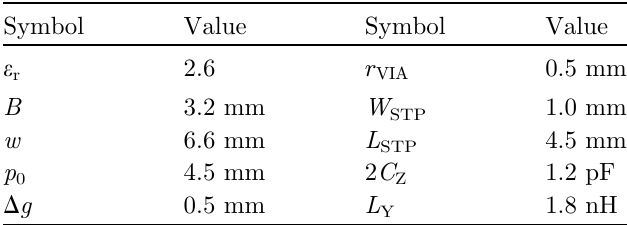
Fig. 3. Dispersion diagram for the unit cell. (a) C-type metaline. (b) N-type metaline. Table 1. Parameters.